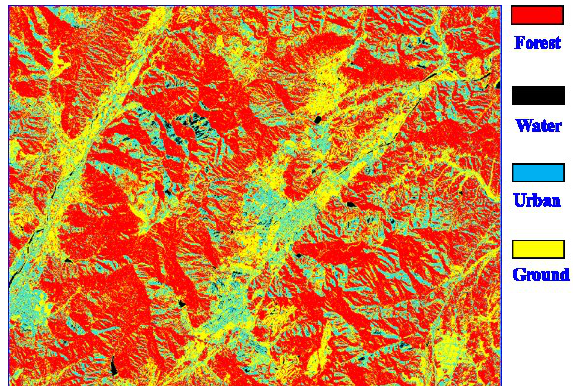
Figure 5. Land cover classified image from the KOMPSAT-3 image in the Yangsan region ICESat points related to the ground were selected by the land cover classified image. Figure 6 shows that the selected 76 ICESat points are located in low-elevation areas of a surrounding ground area. In contrast, most of the points that are in exposed locations in the mountains have been Figure 3. Map of the South Korean peninsula and the Yangsan region for the experiment